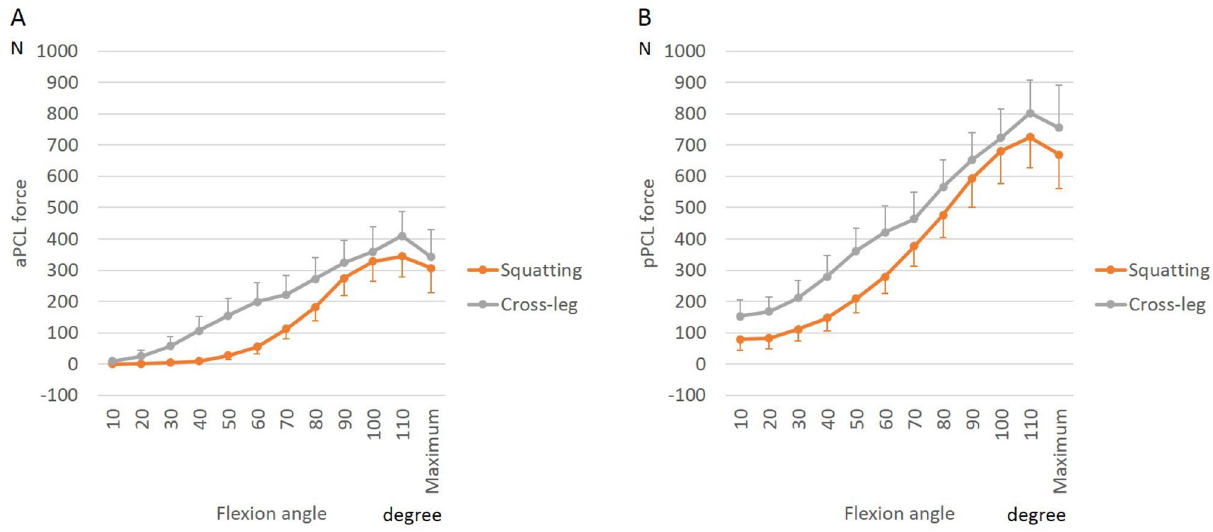
Figure 8. Posterior cruciate ligament (PCL) force during postoperative activities in bicruciate-retaining total knee arthroplasty: ( A ) Anterolateral bundle of the PCL (aPCL); ( B ) Posteromedial bundle of the PCL (pPCL).